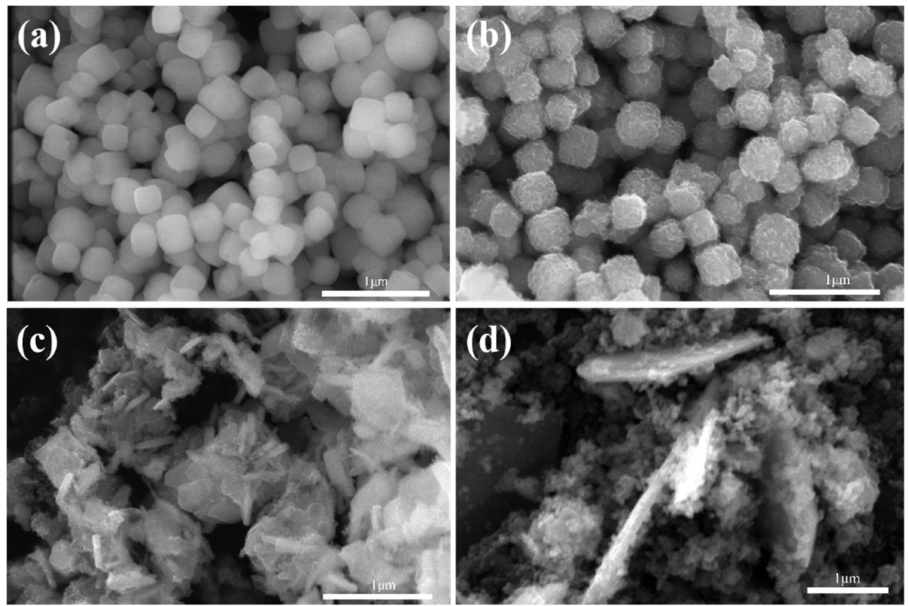
Figure 5. SEM images of Co 3 Sn 2 S 2 at different temperatures ( a )140 ◦ C; ( b ) 160 ◦ C; ( c ) 190 ◦ C; ( d ) 210 ◦